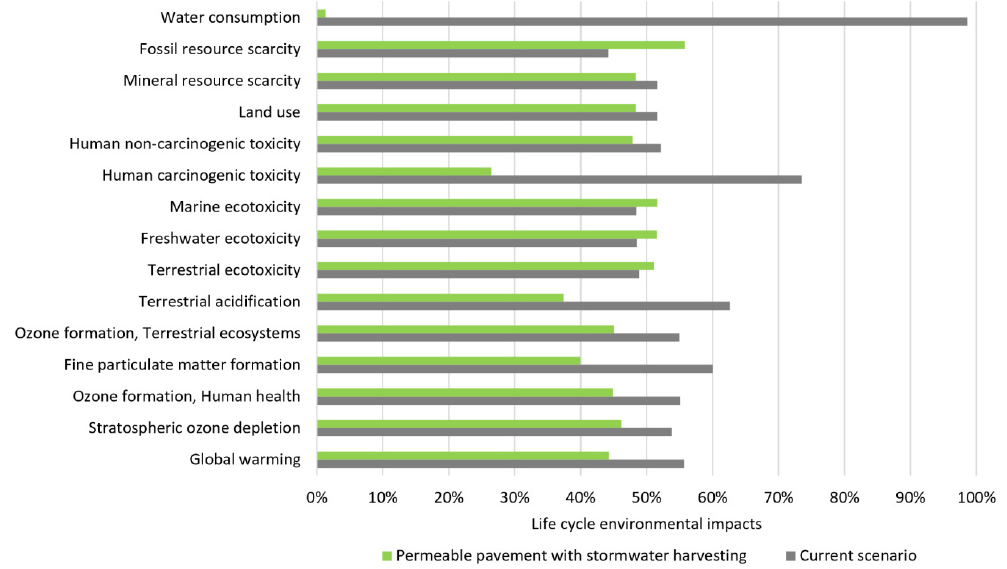
Figure 3. Comparison of environmental impacts through the ReCiPe midpoint method.